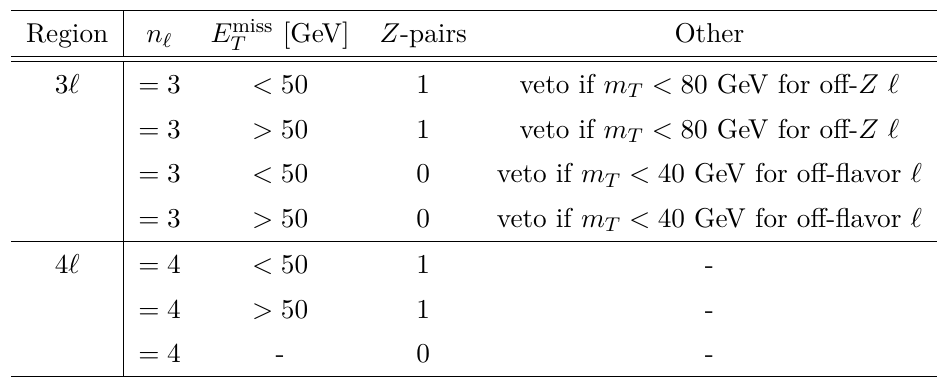
Table 2 . Definitions of the signal regions in the 3 / 4 ‘ search [40]. The 3 ‘ ( 4 ‘ ) SRs are further divided by into m inv [GeV] ∈ [0 , 200] , [200 , 400] , [400 , 600] , [600 , ∞ ) ( [0 , 400] , [400 , ∞ ) ). The off- Z ‘ is a lepton not in the Z -pair, and the off-flavor ‘ is a lepton whose flavor is different from the other two leptons. The cut for off-flavor ‘ is not applied if three leptons have the same flavor. SF-0J, and 5 - 10% ( 5 - 10% ) in SF-1J, where n J ( n = 0 , 1 ) is the number of jets in the